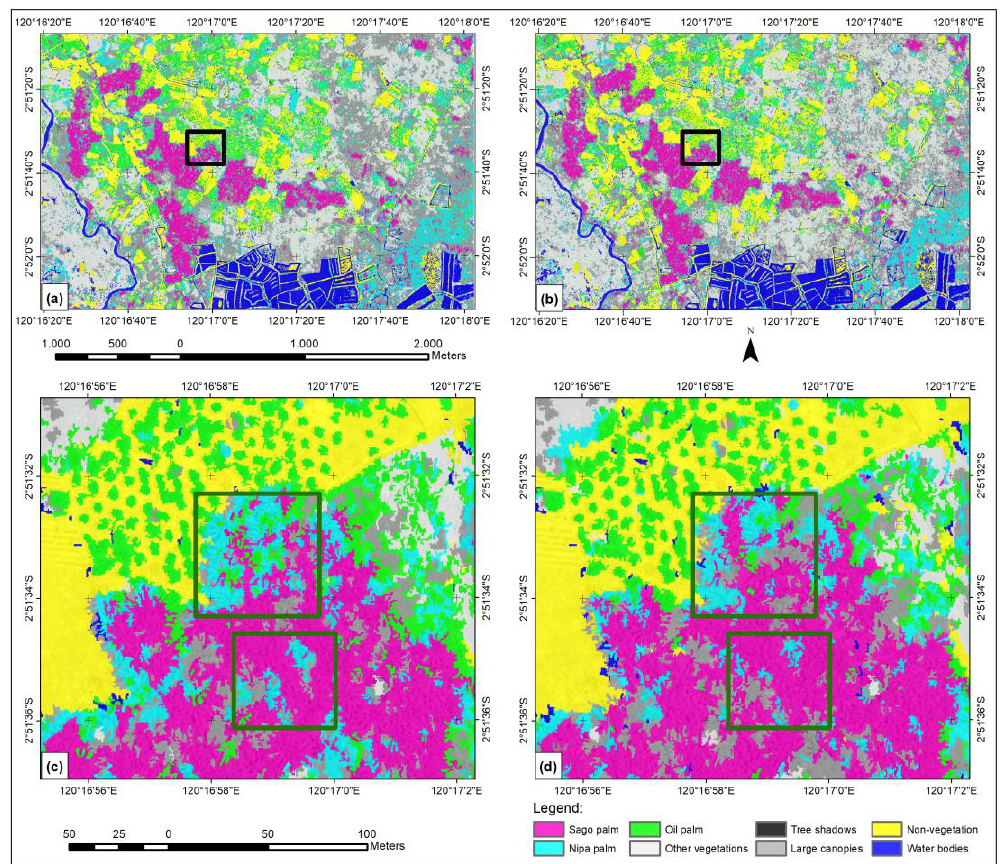
Figure 6. Series showing an SVM-classified image using ( a ) only four spectral bands; ( b ) eight features; ( c ) four spectral bands (magnified image from the black box of panel a); and ( d ) eight features (magnified image from the black box of panel b). SVM: support vector machine.